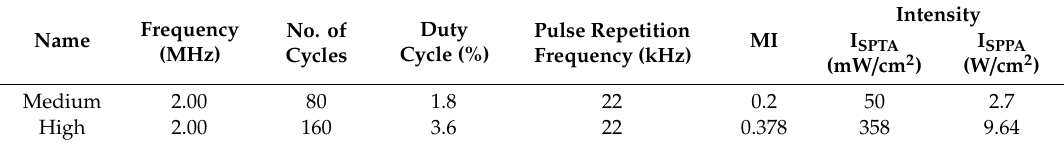
Table 1. US parameters (5 min treatment with US ± microbubbles